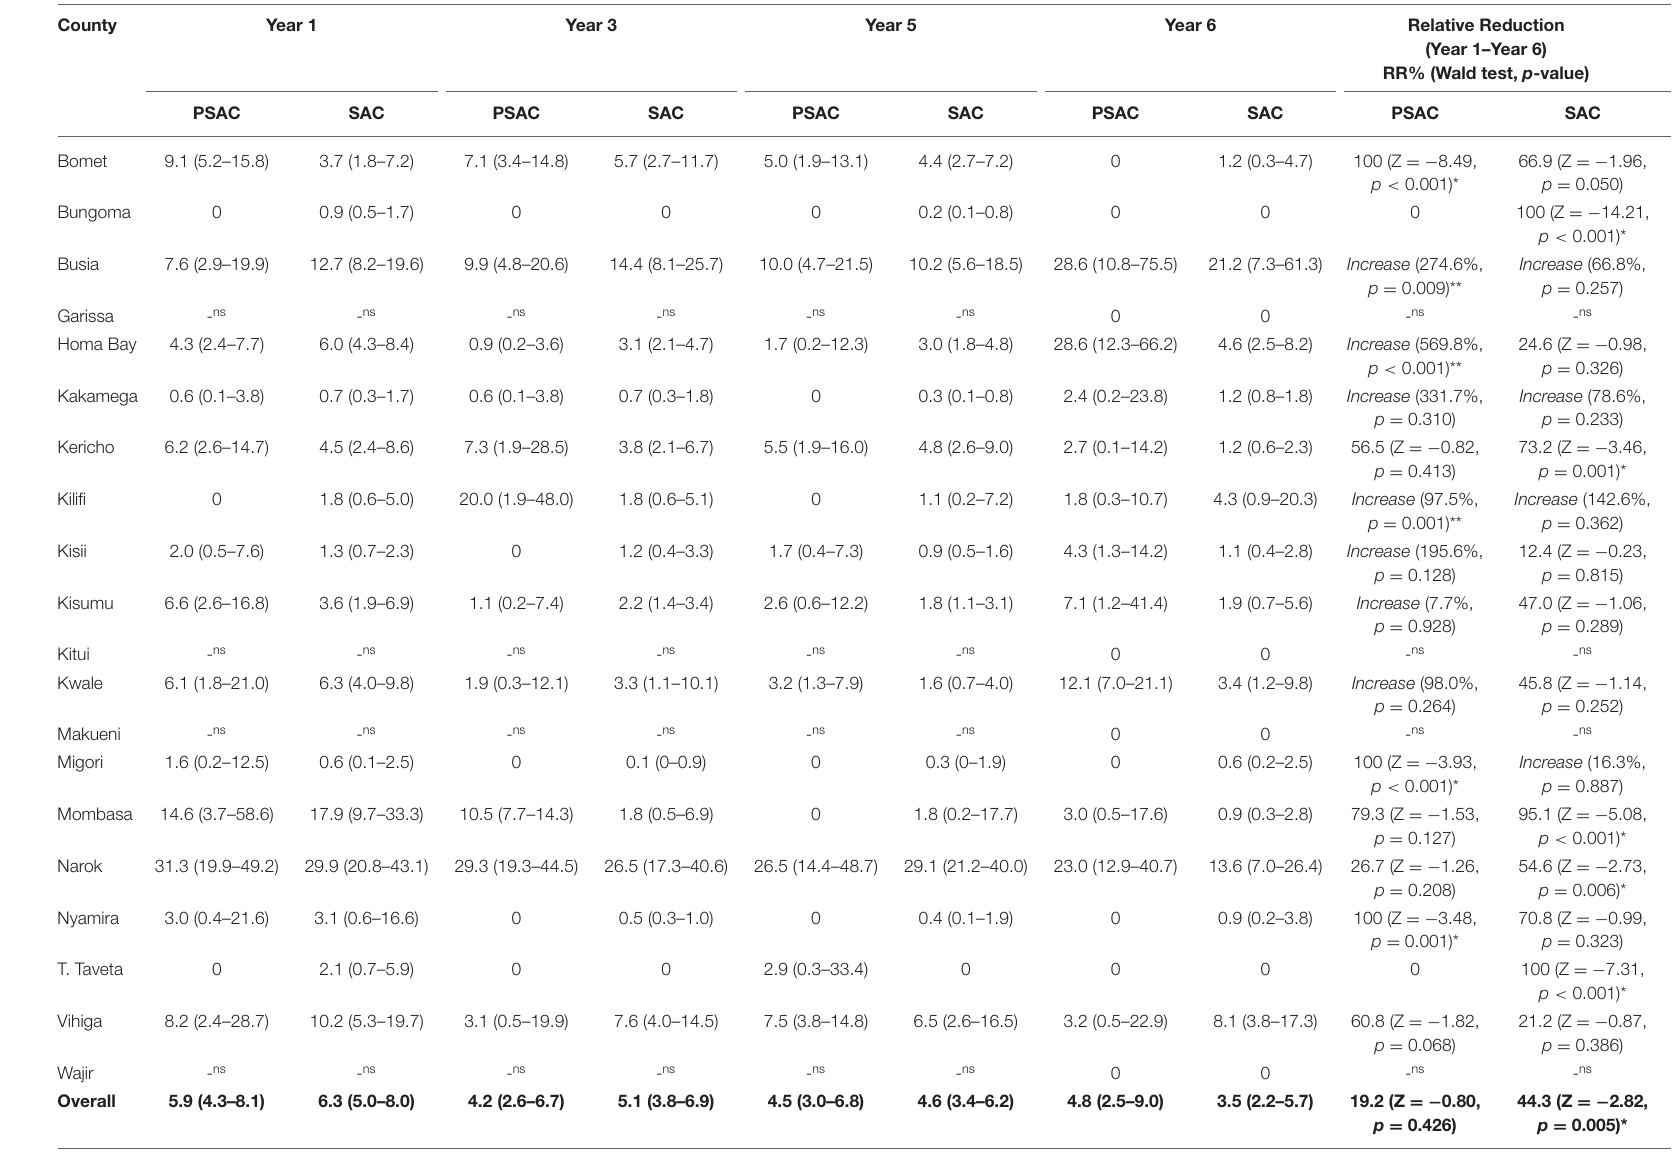
TABLE 4 | Preschool (PSAC) and school (SAC) aged pre-treatment prevalence % (95%CI) and relative reductions % (Wald test: Z-statistic, p -value) for Trichuris trichiura infection in 20 counties in